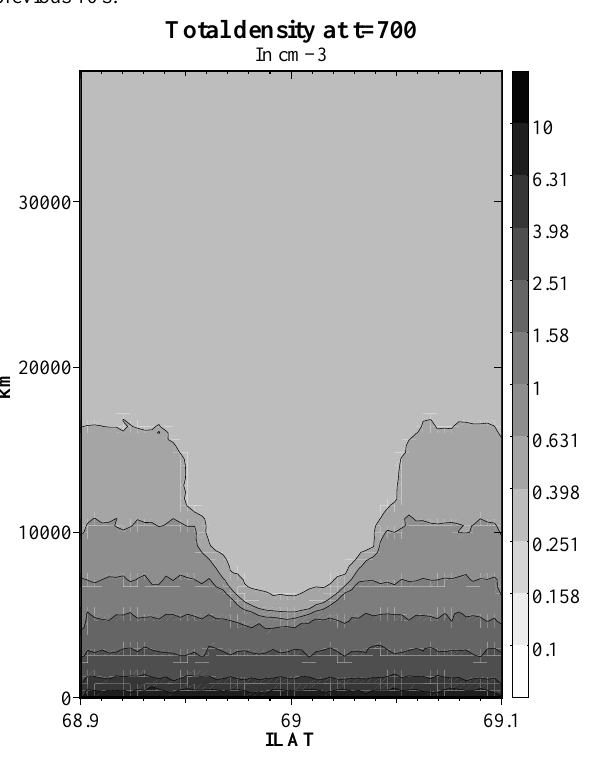
Fig. 3. Electric potential at t = 400s, averaged over the previous 10s.